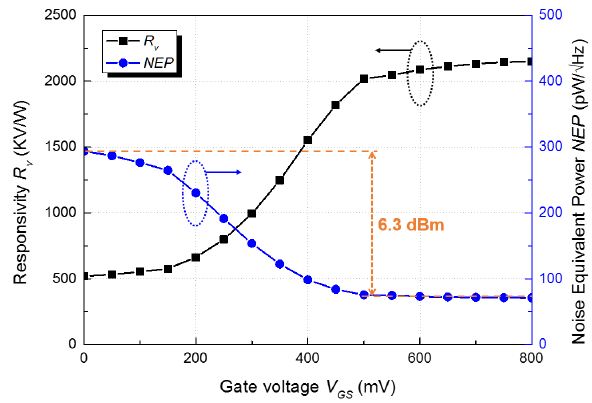
Figure 8. Measured responsivity and noise equivalent power of the proposed detector at 200 GHz.